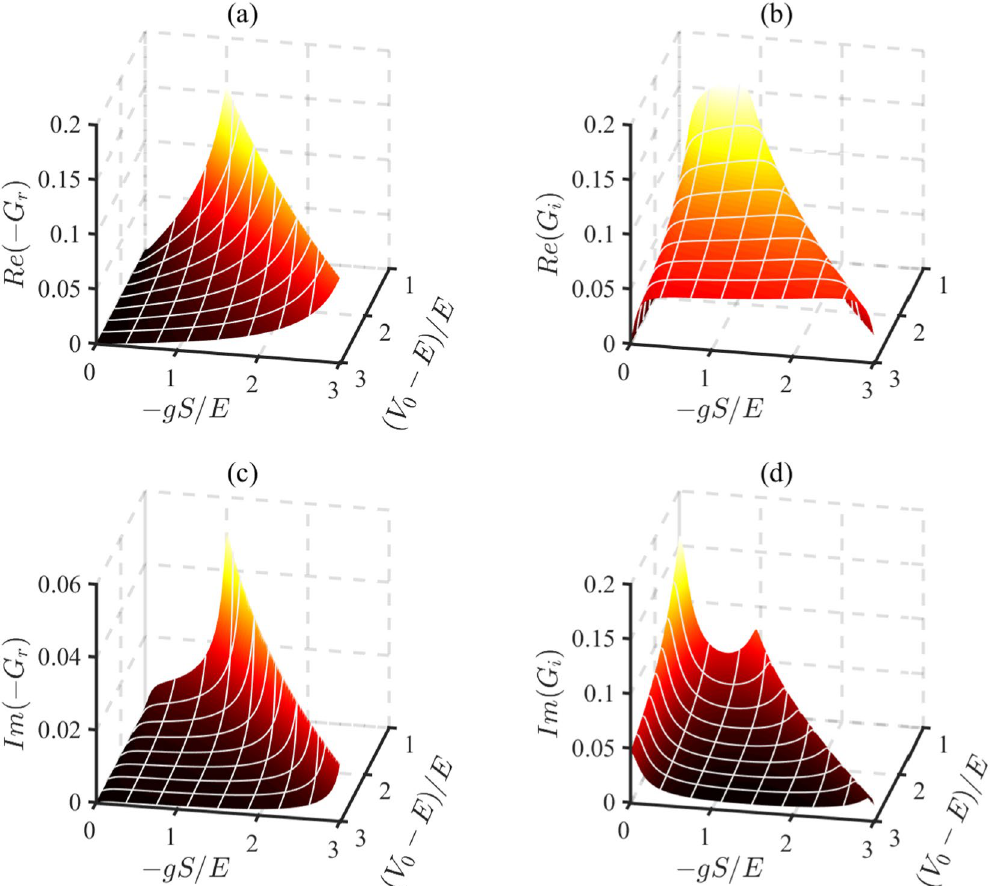
Figure 3. The real parts and the imaginary parts of G r , i are plotted as a function of the insulating gap ( V 0 − E )/ E and s-d coupling − gS / E in FMI. The irrelevant regions where ( V 0 − E )/ E < − gS / E are not plotted. The spin mixing conductance is plotted in units of e 2 / ħa 2 . Here we set γ / E = 0.1 and the other parameters are θ = 0.3 π and = μ 0 / E